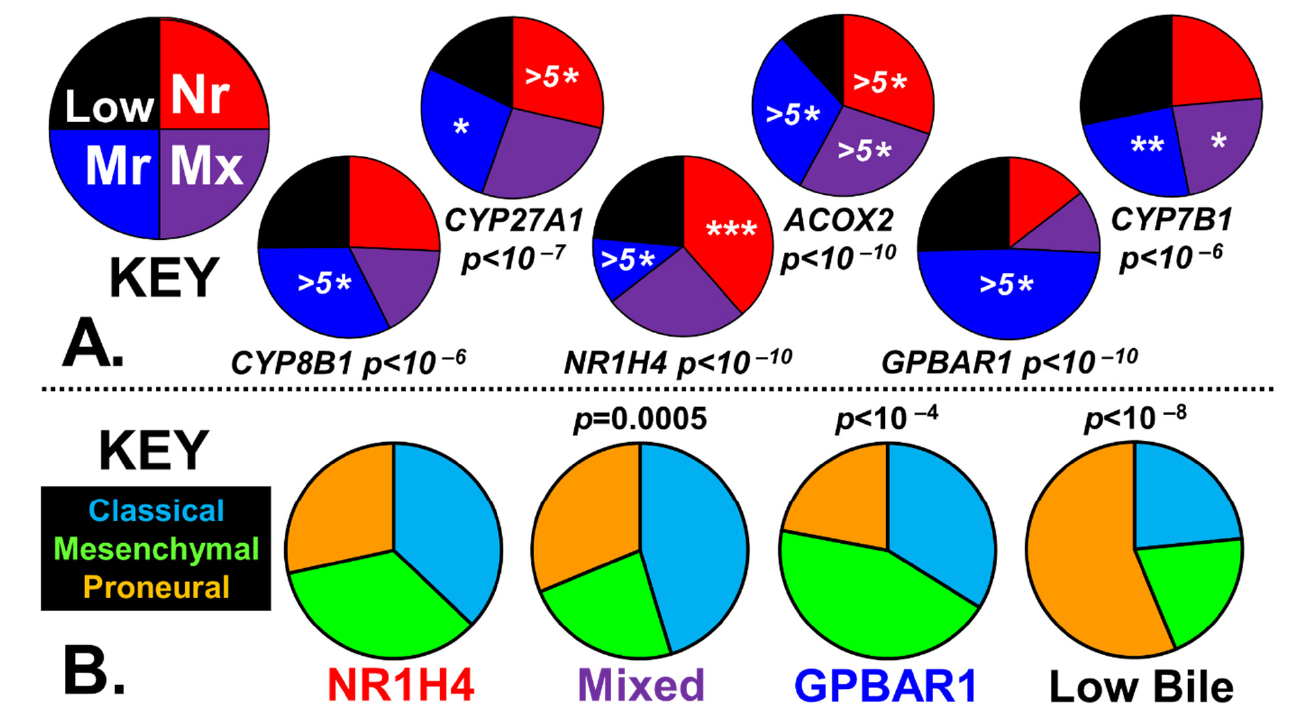
Figure 5. Phenotypes of GBM tumors are stratified into bile salt/receptor stratified phenotypes. ( A ) The median expression levels of the enzyme transcripts used for bile‑generating/bile‑receptor stratification are illustrated in the pie charts, with two statistical tests performed. Below each pie chart is the p ‑value calculated from the chi‑squared statistic, which examines the distribution of transcript medians of the four groups compared to the total population. The stars within the pie chart slices indicate the statistical significance of the comparisons of transcript levels of the three individual bile‑generating/bile‑receptor synthesizing subgroups with respect to ‘Low Bile’. Statistical significance from the t ‑tests are represented by asterisks (*), p < 0.05 *, p < 0.01 **, p < 0.005 ***, and p < 0.0001 (5 * ) . ( B ) Pie charts represent canonical GBM‑subtype fractions within each bile phenotype, with the chi‑squared statistics indicated.